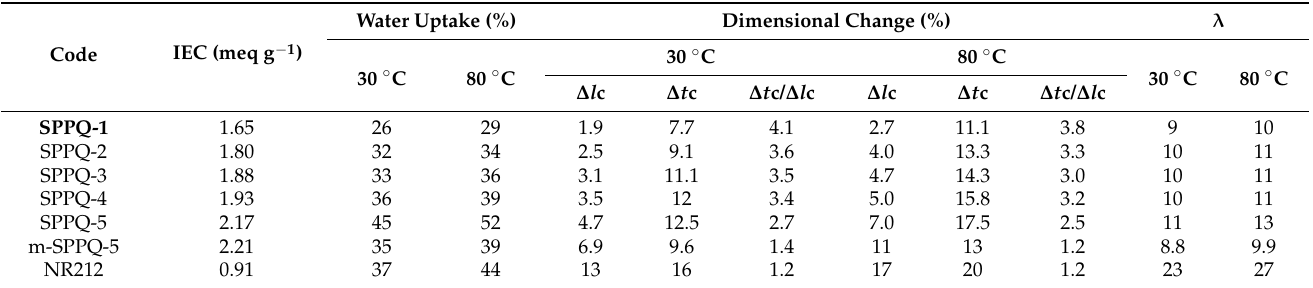
Table 3. Water uptake and size change of SPPQ